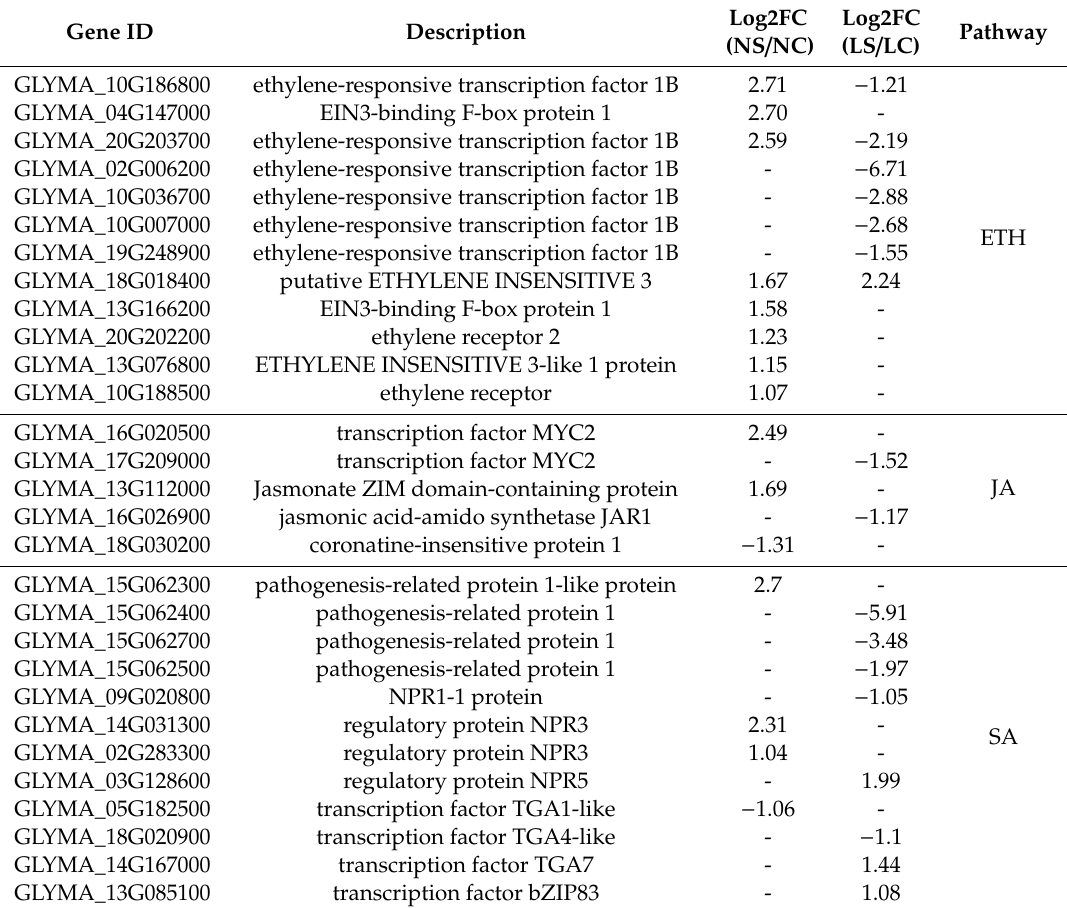
Table 2. DEGs involved in plant defense hormone signaling under two light